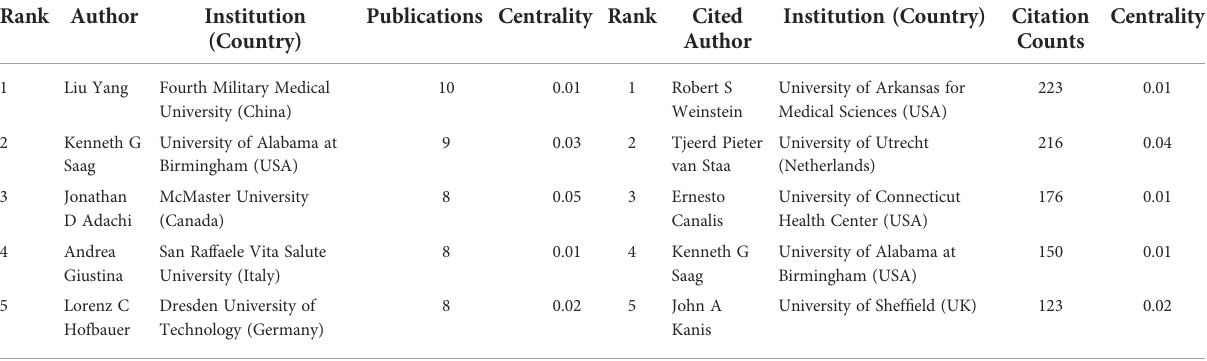
TABLE 4 The top 5 proli fi c authors and cited authors.